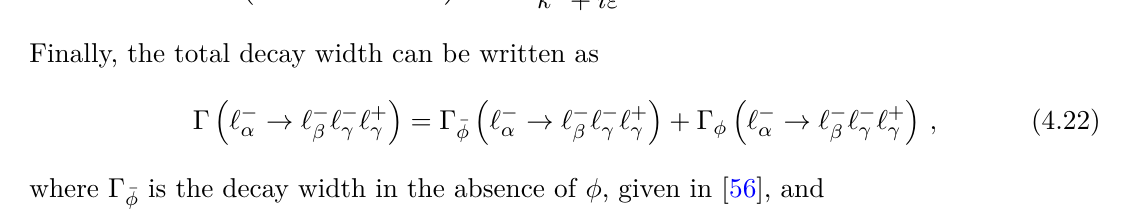
Figure 4 . Tree-level Feynman diagrams contributing to the process ‘ − the effective Lagrangian in eq.